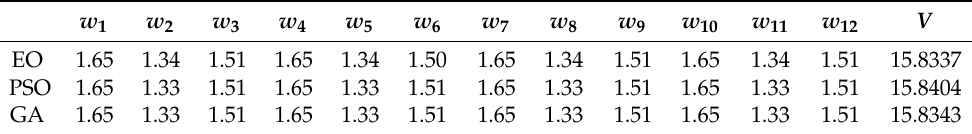
Table 5. Allocated tasks for the AUVs in the large-scale system. w 1 w 2